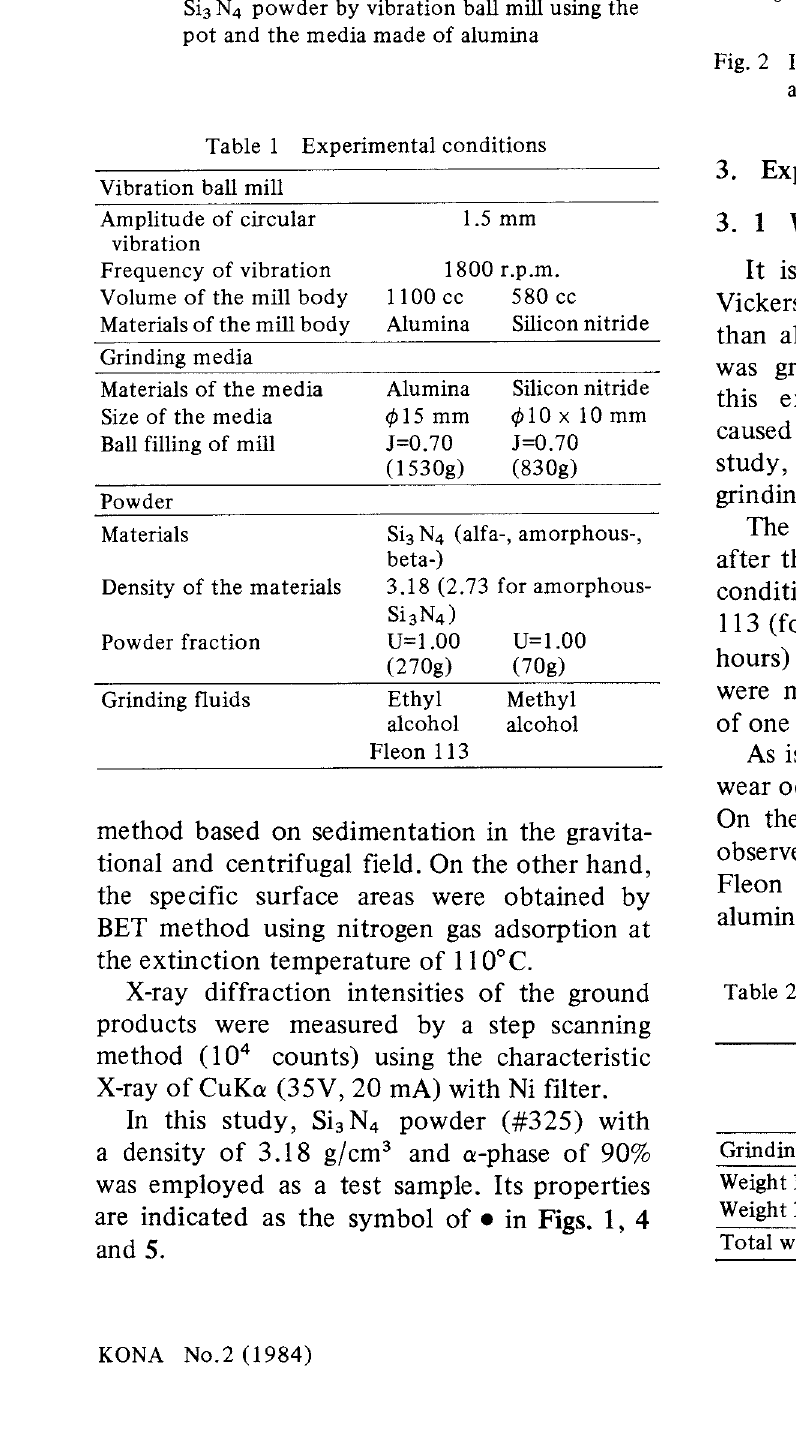
Fig. 1 Particle size distribution of 200 hour ground Si3 N 4 powder by vibration ball mill using the pot and the media made of alumina